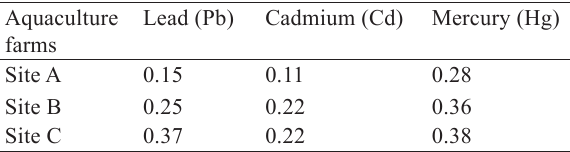
Table 7 Relationships between heavy metal concentrations and farmed rainbow trout length and